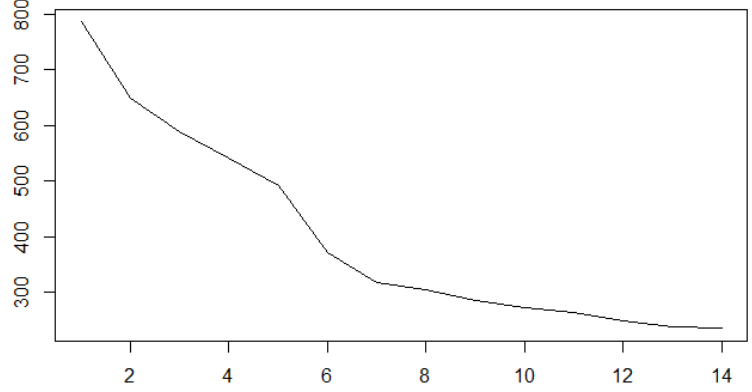
Figure 5. Scree Plot: internal variance change by the number of clusters.